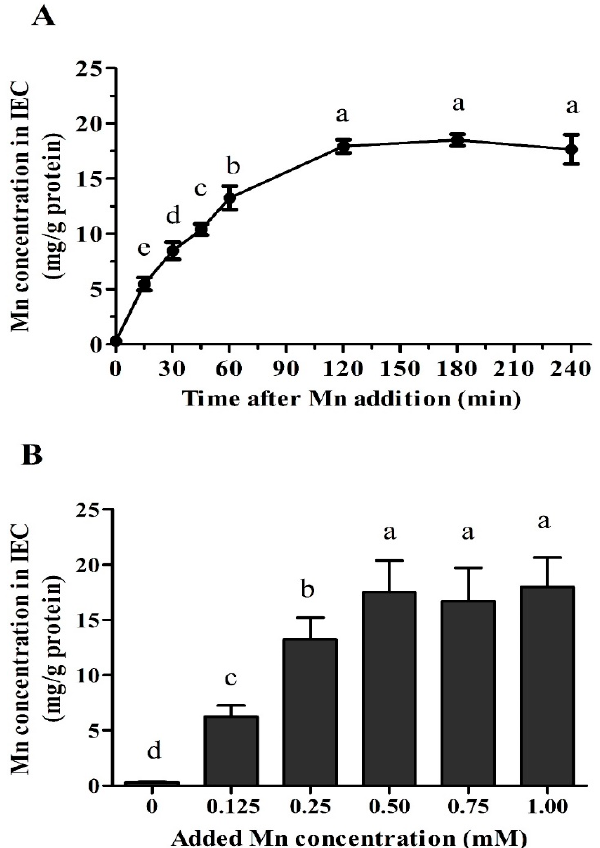
Figure 2. Time- and dose-dependent of Mn uptake in the primary chicken intestinal epithelial cells (IEC). ( A ) Change of Mn uptake with the time in the cells treated with 0.25 mM MnSO 4 . ( B ) Change of Mn uptake with the Mn concentration in the medium at 60 min post-seeding. Values are least-square means ± standard error ( n = 8). a–e Mean values lacking a common letter are different at p < 0.05.